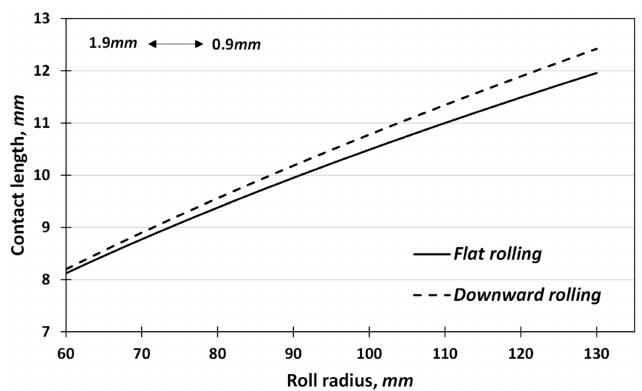
Figure 13. Effect of roll radius on the contact length during VGR.